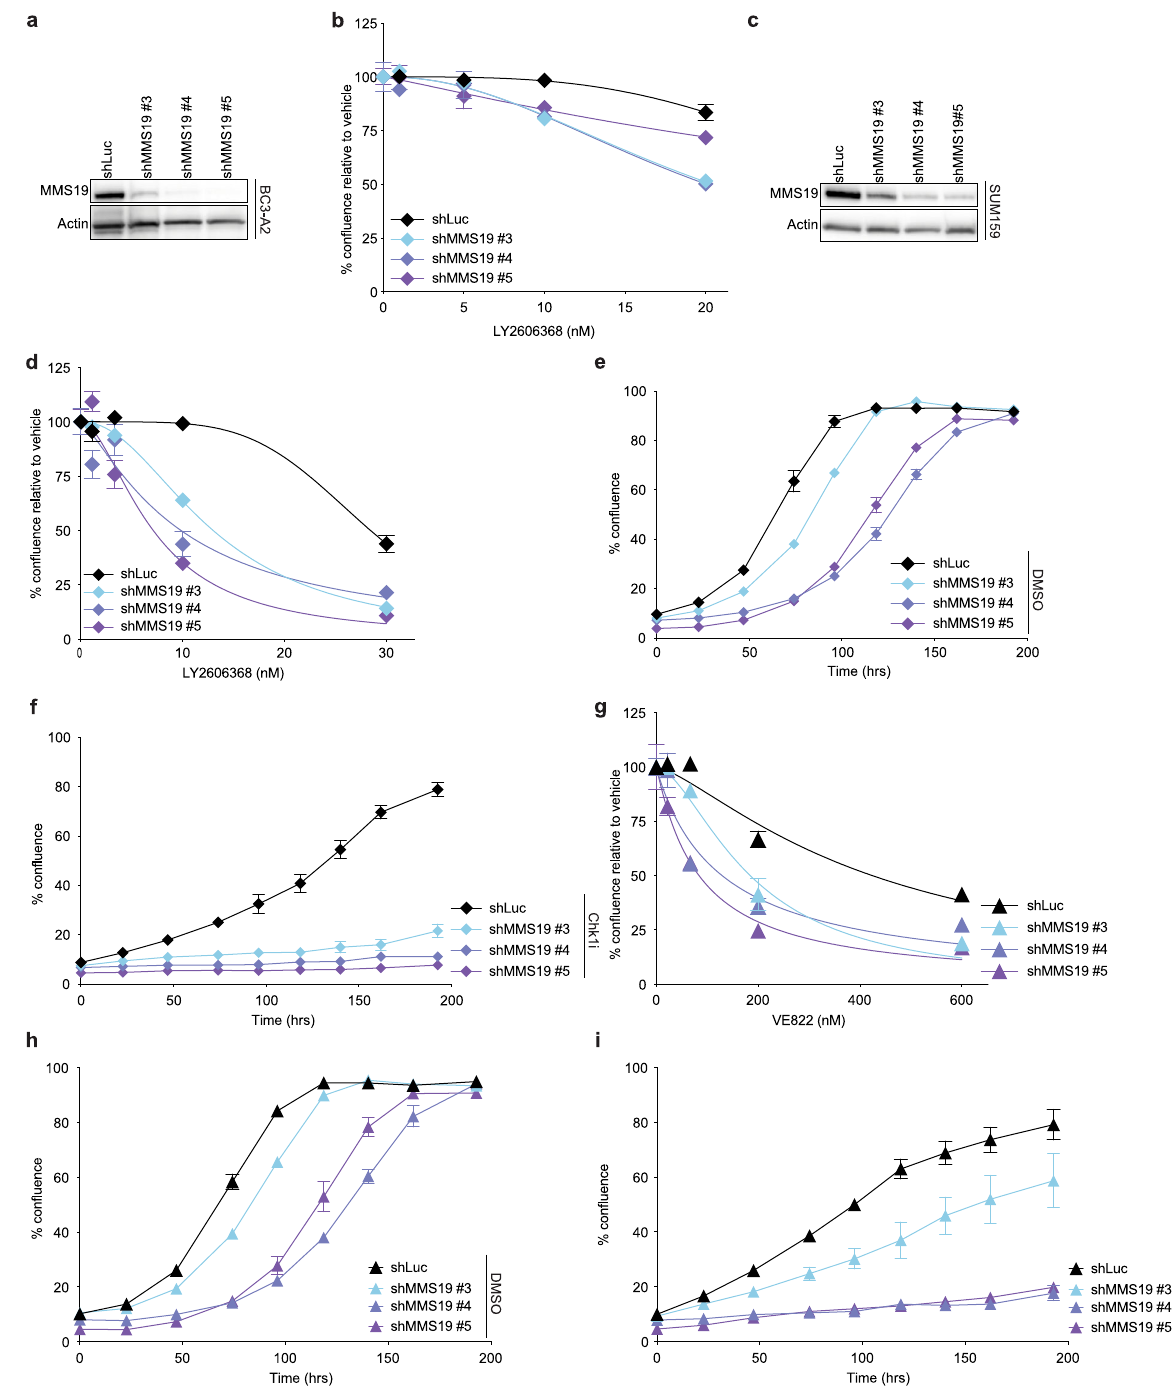
Fig. 2 MMS19-depletion increases sensitivity to Chk1i and ATRi. a Western blot showing ef fi cient shRNA-mediated depletion of MMS19 in BC3-A2 cells. b Control shLuc or MMS19-depleted BC3-A2 cells were plated at a density of 2.5 × 10 3 cells per well in triplicate, allowed to attach overnight, and then treated for 120 h with the indicated doses of Chk1i. Cell growth was monitored by live-cell imaging; percent cell con fl uence is plotted ( y -axis) against the concentration of Chk1i used ( x -axis, LY2606368). c Western blot showing ef fi cient shRNA-mediated depletion of MMS19 in SUM159 cells. d Control shLuc or MMS19-de fi cient SUM159 cells were treated and analyzed as described in panel b. e , f Control shLuc or MMS19-de fi cient SUM159 cells were treated for the indicated times with either DMSO or Chk1i (10 nM Ly2606368). Percent well con fl uence as a function of time is indicated. g Control shLuc or MMS19-depleted SUM159 cells were plated at a density of 2.5 × 10 3 cells per well in triplicate and allowed to attach overnight, and then treated for 120 h with the indicated doses of ATRi. Cell growth was monitored by live-cell imaging; percent cell con fl uence is plotted ( y -axis) against the concentration of Chk1i used ( x -axis, LY2606368). h , i Control shLuc or MMS19-depleted SUM159 cells were treated for the indicated time periods with either DMSO or ATRi (200 nM VE-822). Percent well con fl uence as a function of time is indicated. b , d – i Data point — mean; error bars — SEM of three independent experiments for all graphs except for ( e ) and ( f ) (two independent